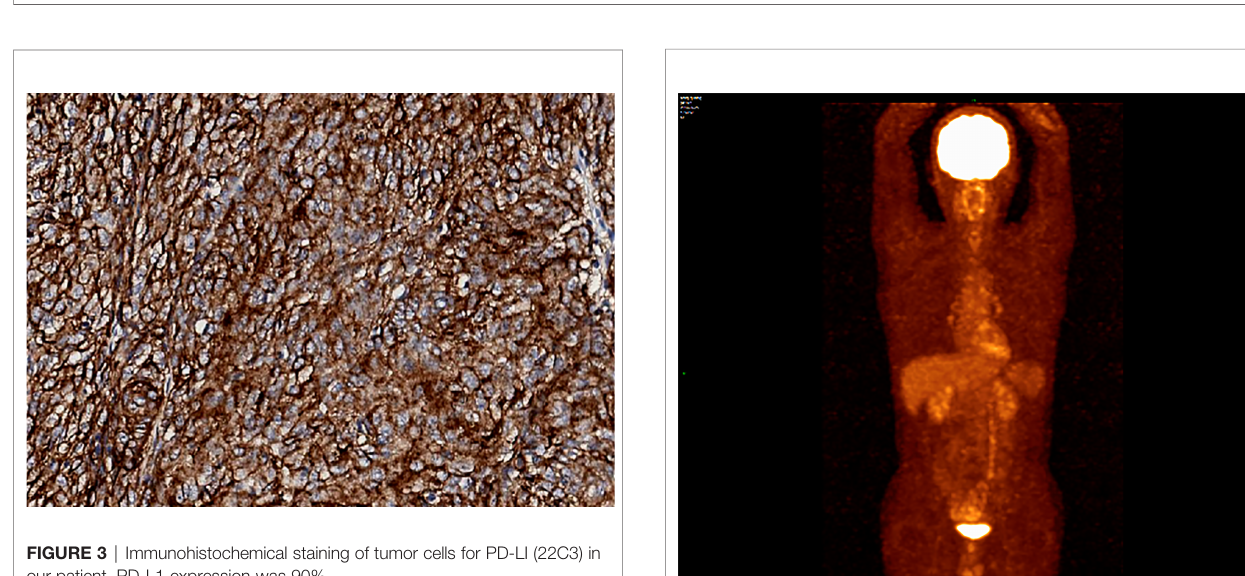
FIGURE 2 | (A, B) Hematoxylin-eosin staining of primary tumors: small intestinal spindle cell tumors. (C) Immunohistochemical staining for CD21 (C1) , CD23 (C2) and CD35 (C3) .